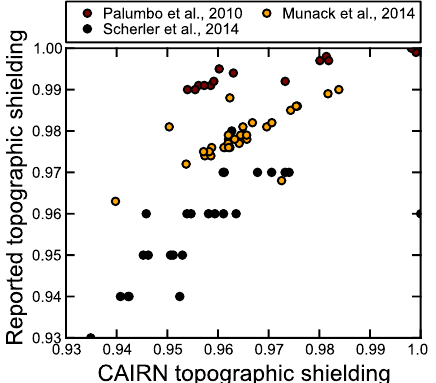
Figure 3. Topographic shielding ( S t ) calculated using (cid:49)φ = 5 ◦ , (cid:49)θ = 8 ◦ plotted as a function of reported